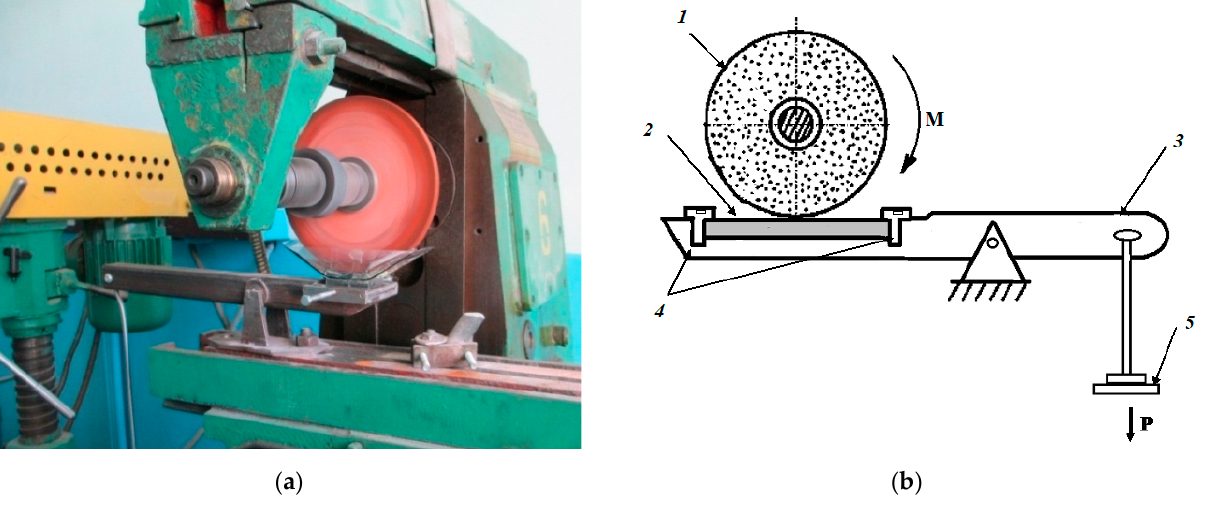
Figure 2. ( a ) General view of the installation for abrasive wear testing of specimens with hard- anodized layers synthesized on their surface and ( b ) schematic diagram of this device: 1—abrasive wheel; 2—specimen; 3—lever transmitting force; 4—specimen fixation elements; 5—weights; P—load. Reprinted from Ref. [52].